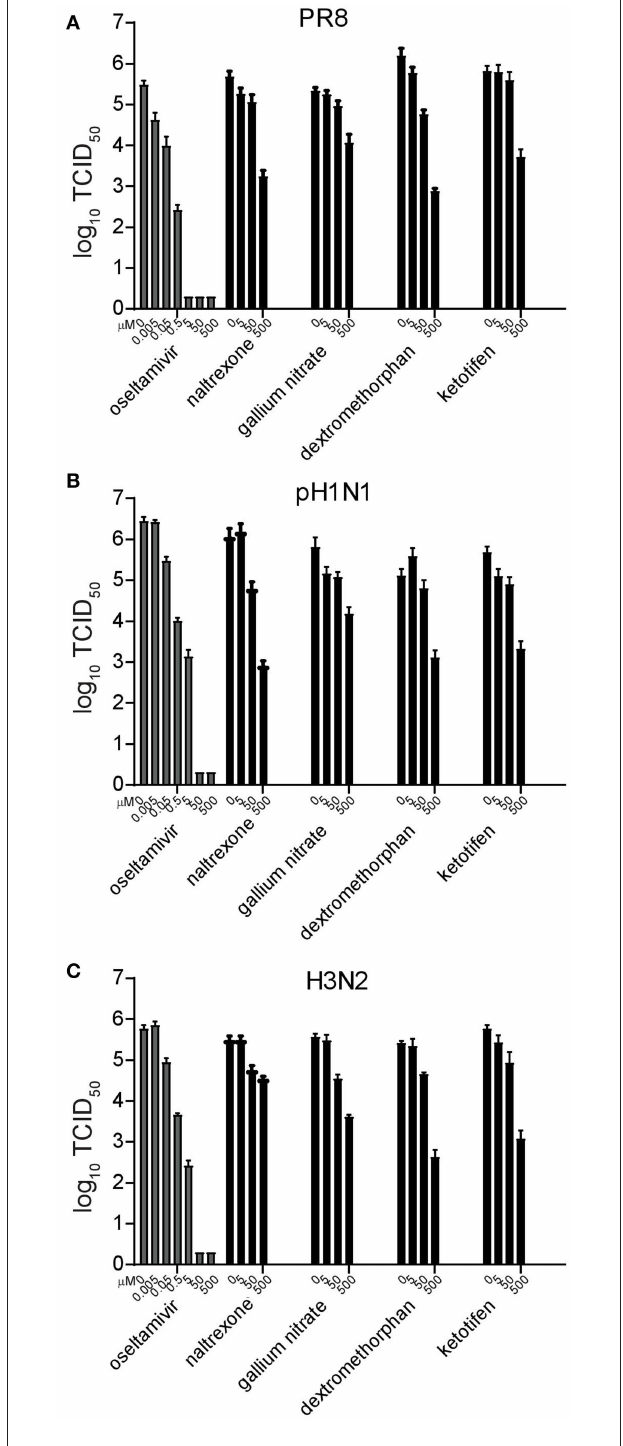
FIGURE 2 | Validation and inhibitory concentration determination of candidate drugs. Replication inhibition of the different drugs. MDCK cells were pretreated for 8h and infected with the influenza strains A/Puerto Rico/8/34 (PR8) (A) , A/Mexico/InDRE4487/2009 (H1N1pdm09) (B) , or A/Victoria/36/2011 (H3N2) (C) at a MOI of 0.01 in the presence of 10-fold serial drug dilutions. After